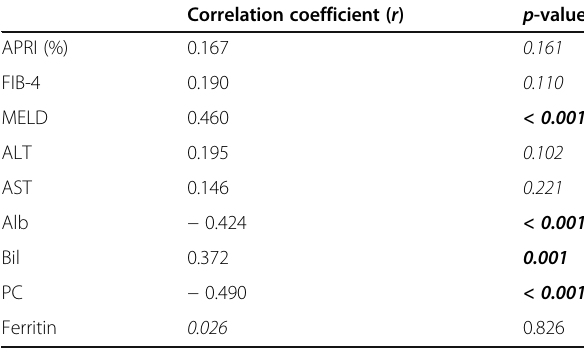
Table 3 Correlation between serum NOGO-B, MELD, APRI, and FIB-4 scores and other laboratory parameters in the three groups of